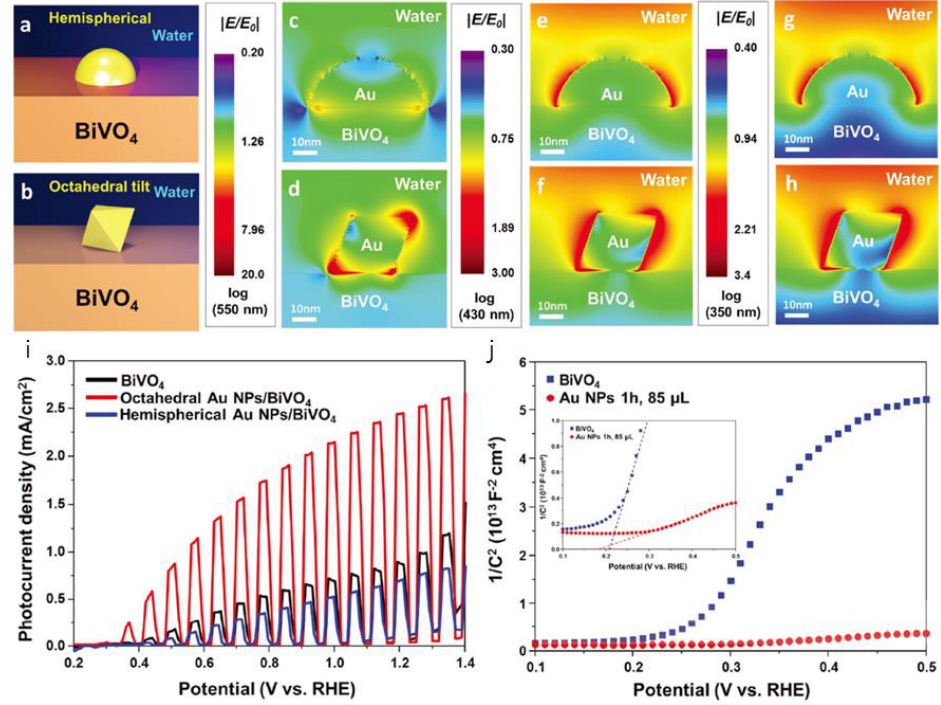
Figure 3. Finite-difference time-domain simulation results of BiVO 4 with ( a ) hemispherical Au NP and ( b ) octahedral Au NP. The simulations are performed under wavelengths of ( c , d ) 550 nm, ( e , f ) 430 nm, ( g , h ) 350 nm. ( i ) PEC performances of the samples. ( j ) Mott-Schottky plot of bare BiVO 4 and BiVO 4 with octahedral Au NPs under dark conditions (Frequency: 1 kHz, amplitude: 10 mV). Reprinted